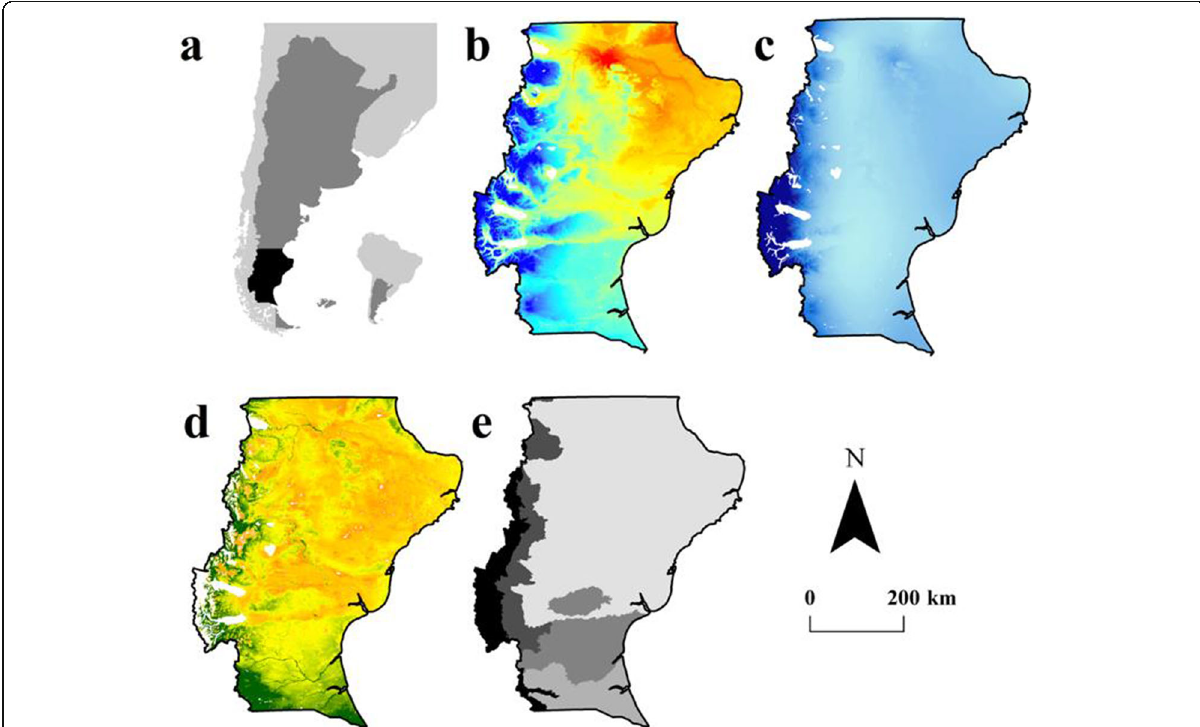
Fig. 1 Characterization of the study area. a Location of Argentina (dark grey) and Santa Cruz Province (black). b Mean annual temperature (8.6 to 13.5 °C) where blue is low and red is high. c Mean annual rainfall (136 to 1681 mm year − 1 ) where dark blue is higher values. d normalized difference vegetation index (NDVI) (0 – 1) where red is low and green is high. e Main ecological areas, where light grey is dry steppes (central plateau, shrub-steppes of San Jorge Gulf, and mountains and plateaus), grey is humid steppes (humid and dry Magellanic grass steppes), medium grey is shrublands, dark grey is sub-Andean grasslands, and black is forests and alpine vegetation (modified from Oliva et al.